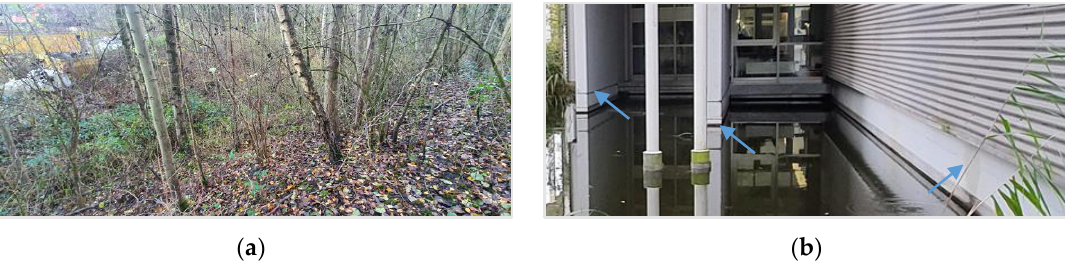
Figure 11. Significant differences between the reference map and the map generated by the LISFLOOD-FP: ( a ) the area for which the DEM data were incorrect; ( b ) the front view of the structure in the pond.